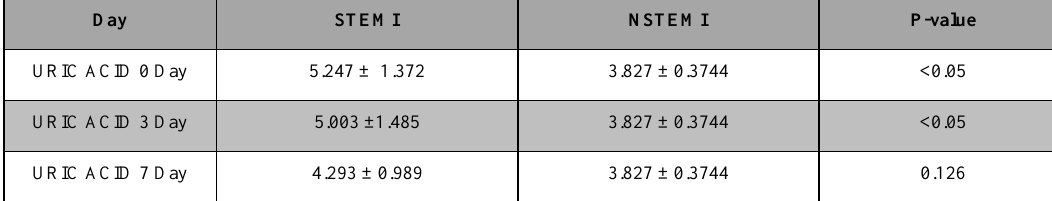
Table 2. Comparision of uric acid level between STEMI and NSTEMI patients.